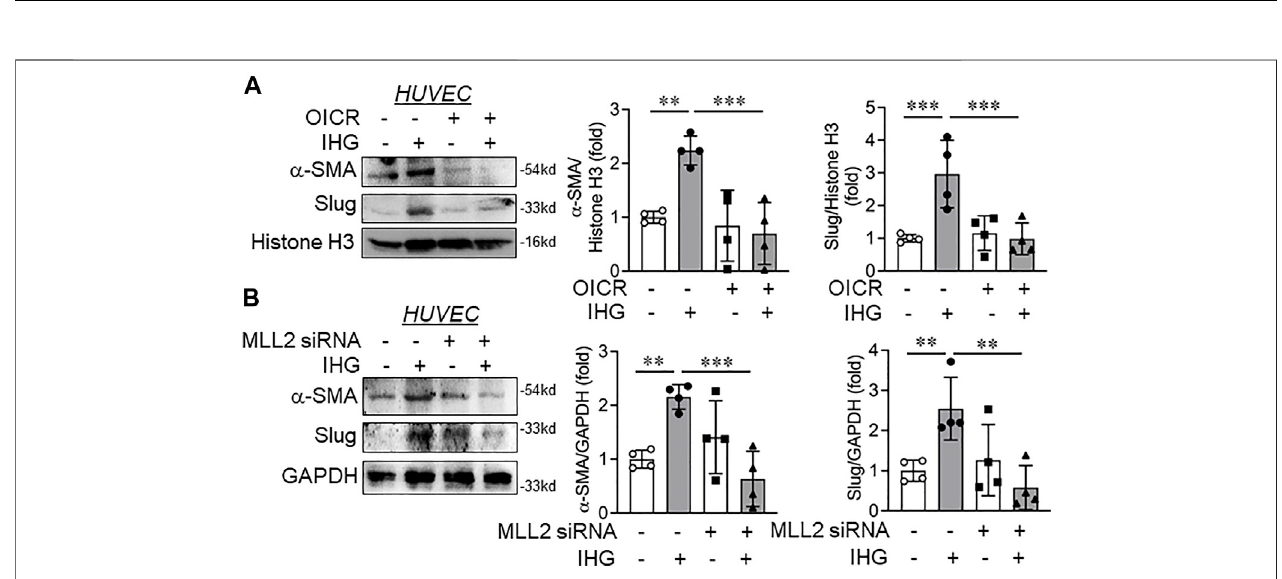
FIGURE 6 | Catalytic inhibition or siRNA-mediated knockdown of MLL blocked intermittent high-glucose-dependent mesenchymal switch of endothelial cells. (A) HUVEC were exposed to intermittent high-glucose treatment condition in combination with OICR-9429 and incubated for a total of 5 days followed by immunoblot analysis by probing for α -SMA and Slug along with densitometry quanti fi cation of the blots ( n = 4). (B) HUVEC were transfected with MLL2 speci fi c siRNA followed by challenging with intermittent high glucose and incubation for a total of 5 days. Resultant cell lysate was immunoblotted and probed for α -SMA and Slug along with densitometry quanti fi cation of the blots ( n = 4). Values represent the mean ± SD. ** p < .01, and *** p < .001, by the two-stage linear step-up procedure of Benjamin, Krieger, and Yekutieli test.